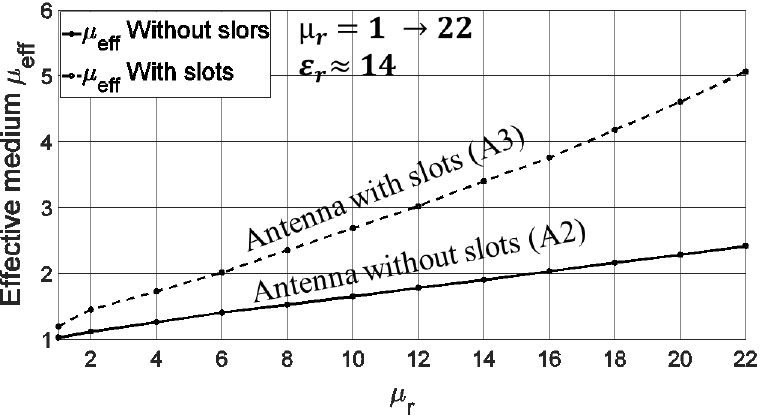
Figure 4. Effective medium in function of the relative permeability for both miniaturized antennas: without slots (A2) and with two slots (A3).